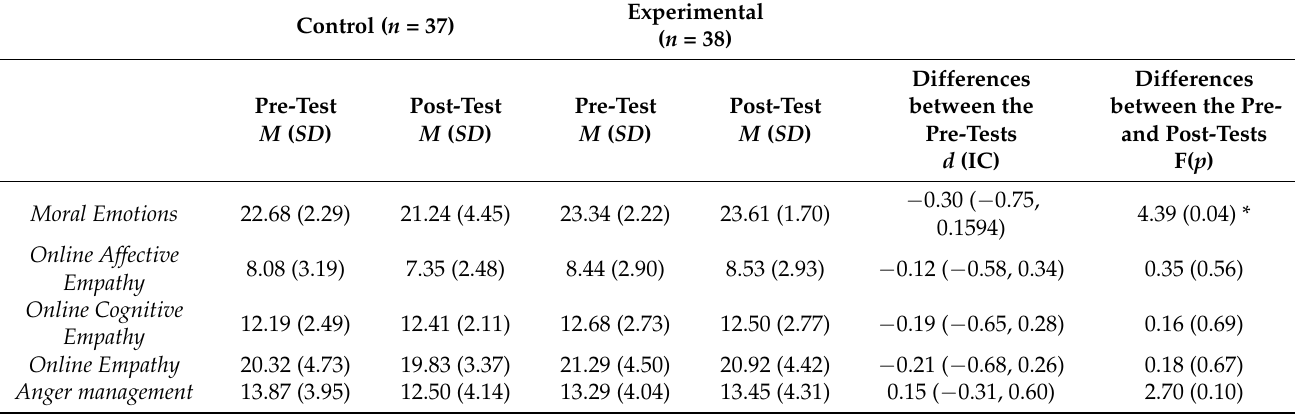
Table 7. Differences in pre-and post-test scores in moral emotions , anger management , and online empathy in